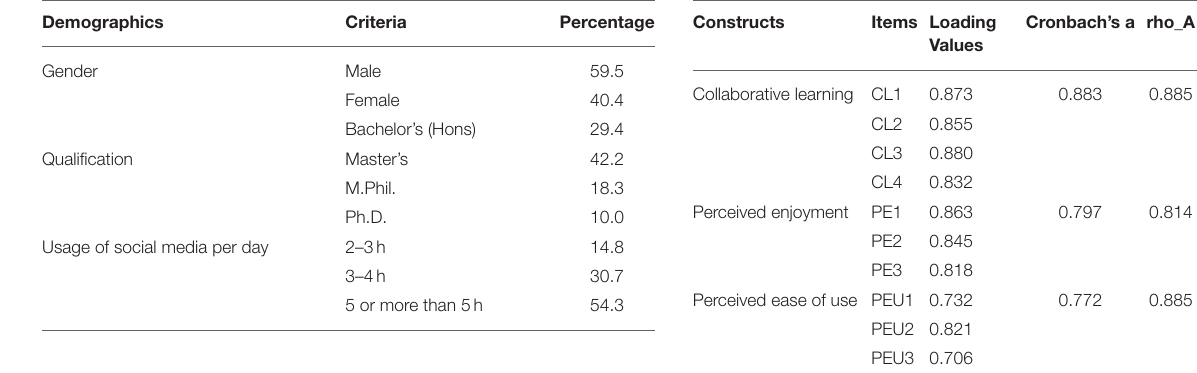
TABLE 1 | Respondents’